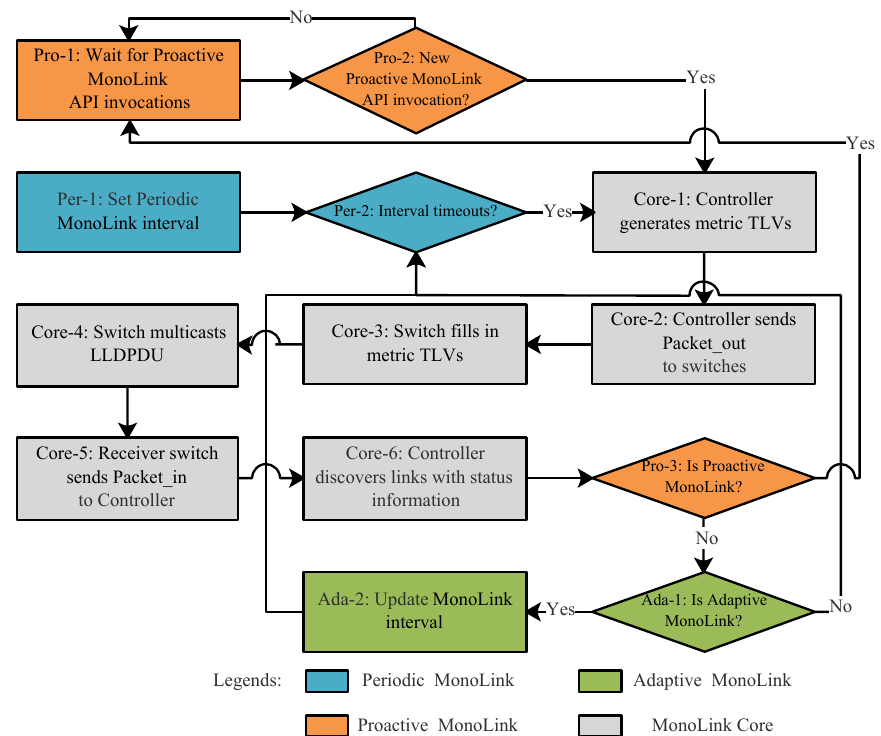
Figure 3. The workflow of MonLink.